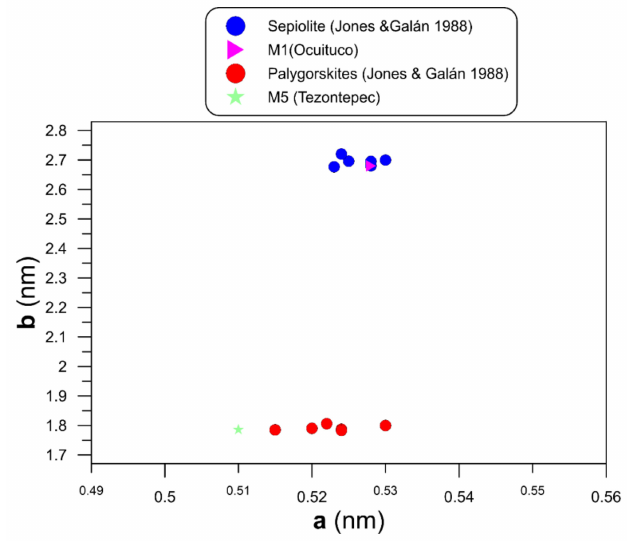
Figure 10. Cell parameters ( a,b ) for sepiolite of sample M1 (Ocuituco) and palygorskite of sample M5 (Tezontepec). Comparison with the cell parameters of the same minerals reported by Jones and Gal á n